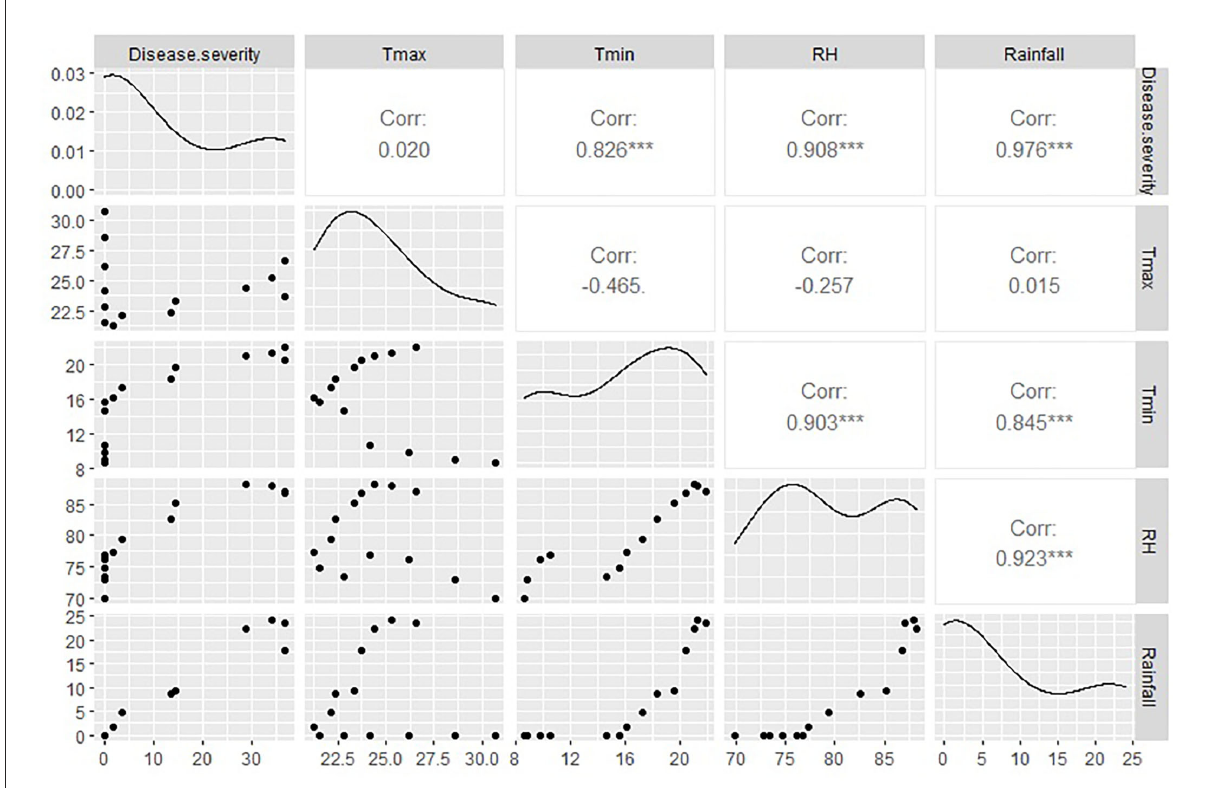
FIGURE6 Anthracnose disease severity in relation to weather parameters (rainfall, humidity, temperature) during 2012-13 at ICAR-DOGR. ***Highly significant at <